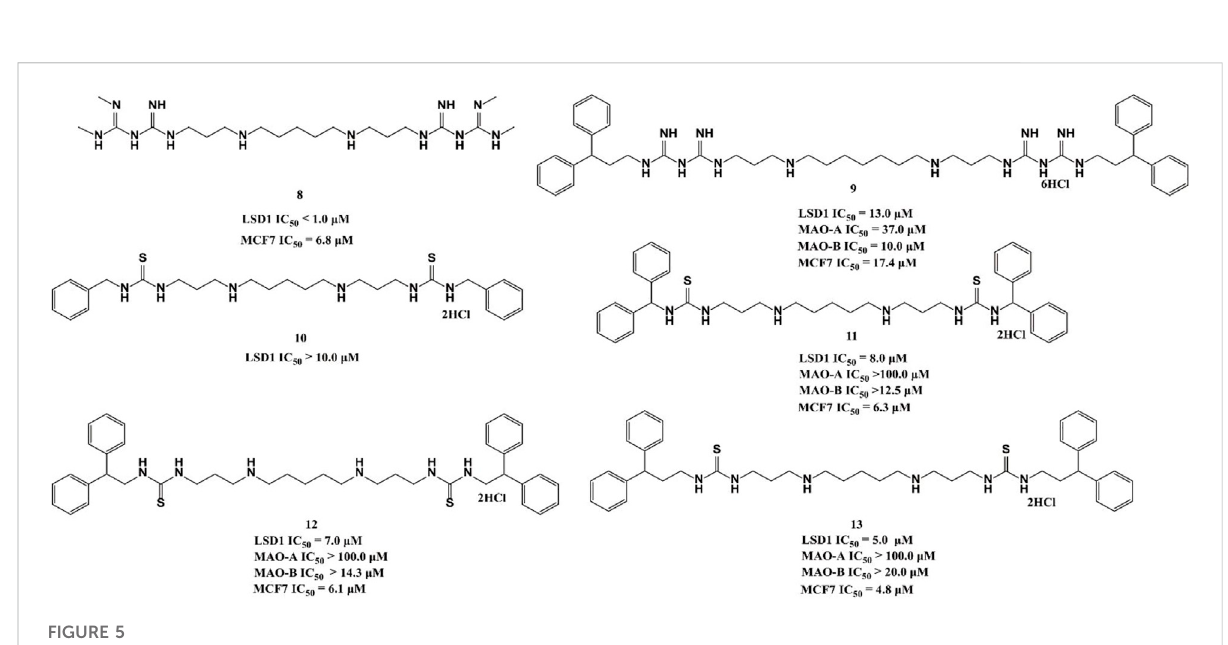
FIGURE 5 Chemical structures of polyamine analogue-based LSD1